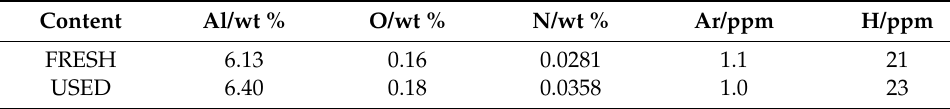
Table 2. Content of elements in investigated powders. Content Al/wt % USED Error: Al ± 0.33; O ± 0.006, N ±